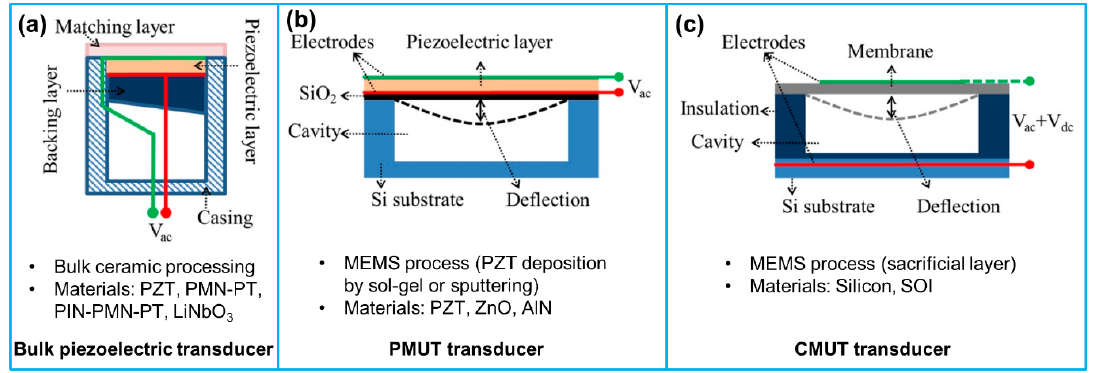
Figure 4. Cross-sectional structures of three different kinds of ultrasound transducers: ( a ) piezoelectric ultrasound trans- ducer; ( b ) piezoelectric micromachined ultrasound transducer (PMUT); ( c ) capacitive micromachined ultrasonic transducer (CMUT). Reprinted from [55] with permission.